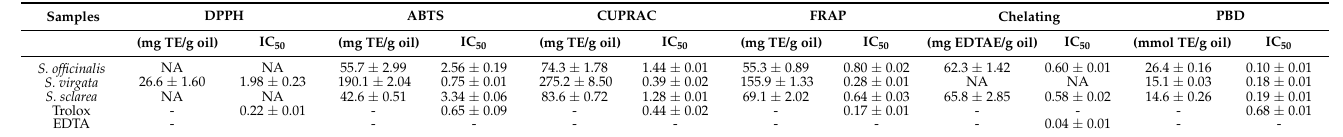
Table 2. Antioxidant activity of Salvia essential oils